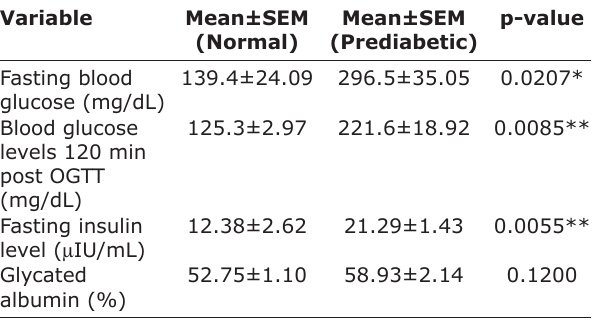
Table-1: Biochemical analysis of prediabetic rats versus control. Variable